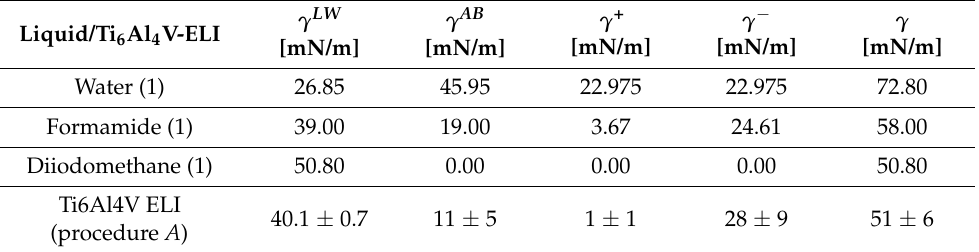
Table 3. The values of the Lifshitz–van der Waals ( γ LW ), electron-acceptor ( γ + ) and electron- donor ( γ − ) parameters of the acid-base ( γ AB ) components of model liquids’ (water, formamide and diiodomethane) surface tension taken from the literature [19–22,29] and those of Ti6Al4V ELI prepared according to procedure A , B or C and calculated from Equation (3) at 293